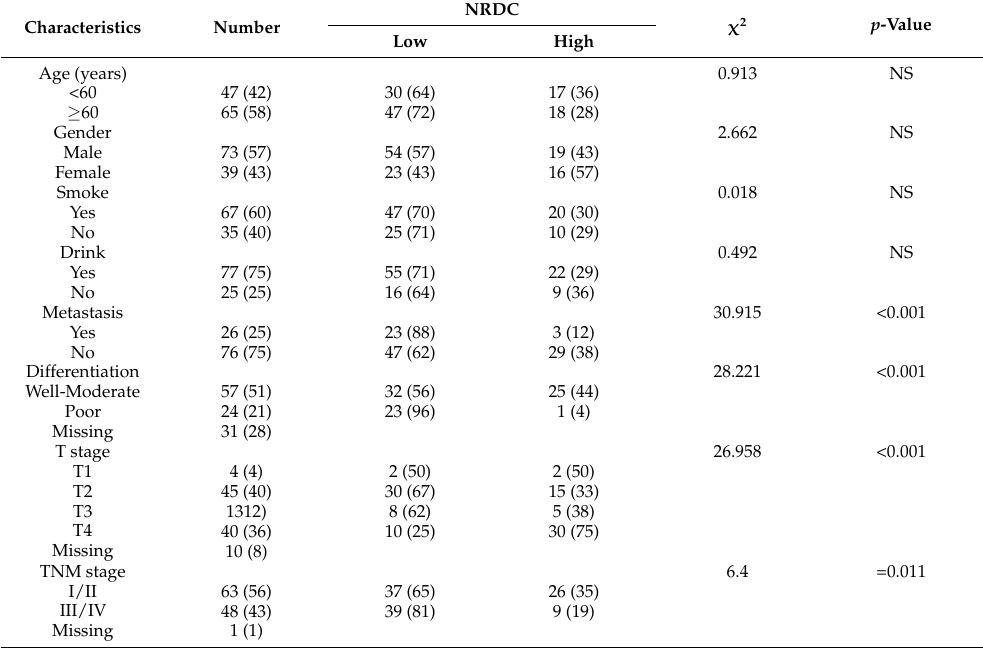
Table 1. Characteristics of patients with pancreatic ductal